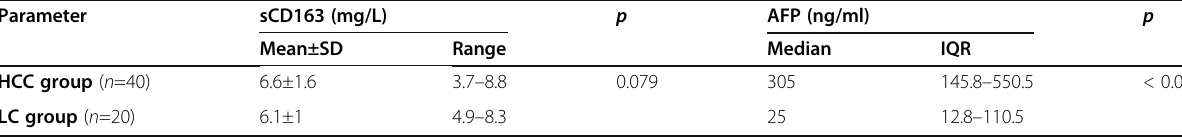
Table 2 Comparison between the 2 studied groups as regards baseline sCD163 and AFP Parameter sCD163 (mg/L)